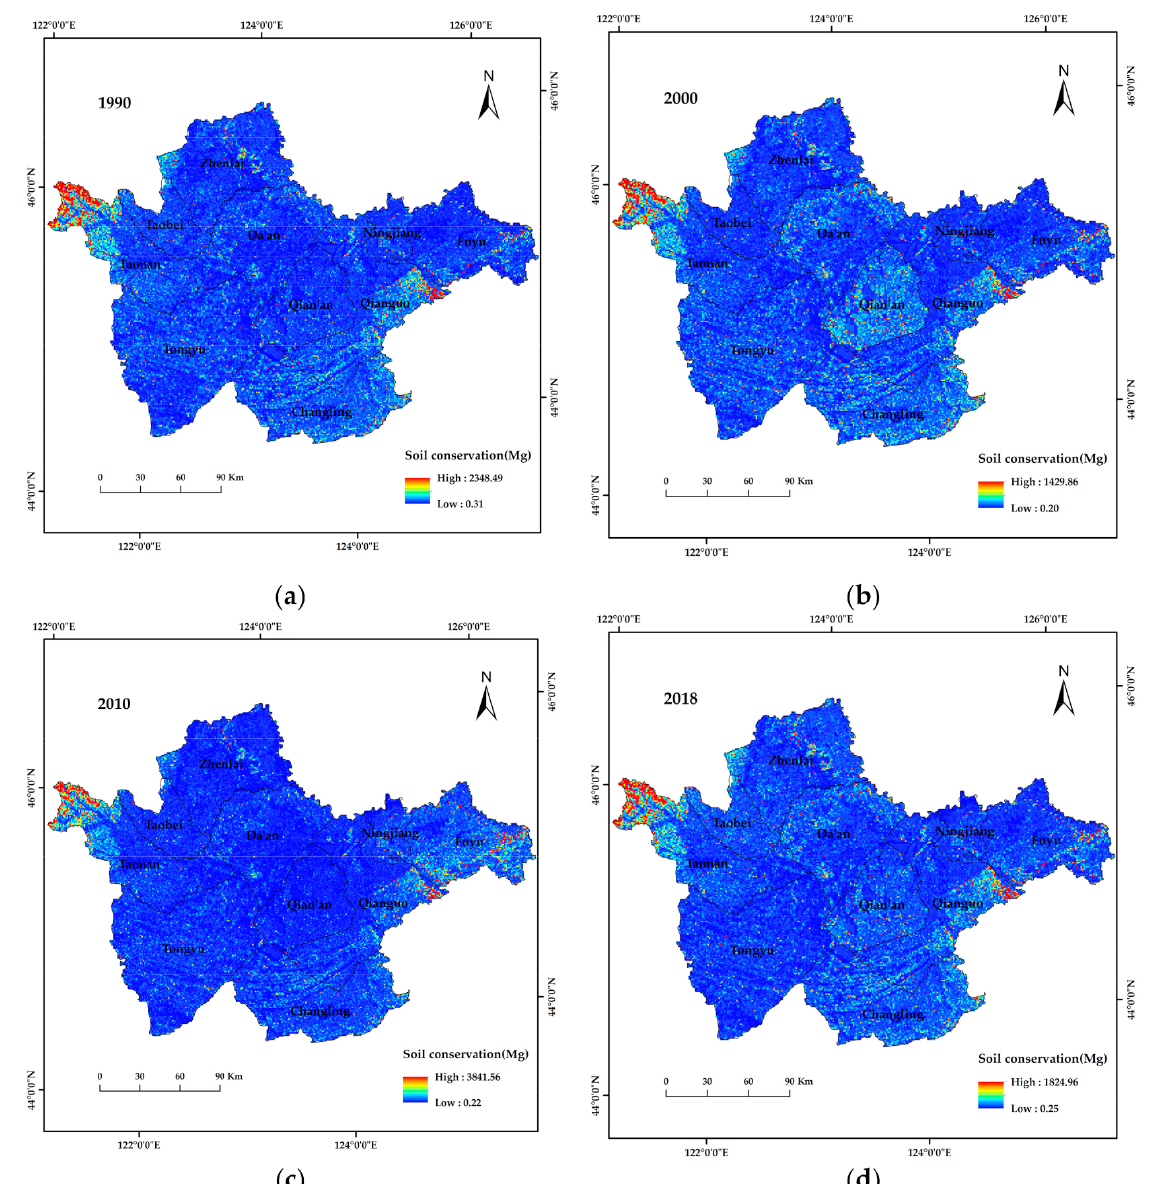
Figure 6. Spatial distribution of soil conservation in western Jilin Province from 1990 to 2018. ( a – d ), spatial distribution of soil conservation in western Jilin Province in 1990, 2000, 2010 and 2018,